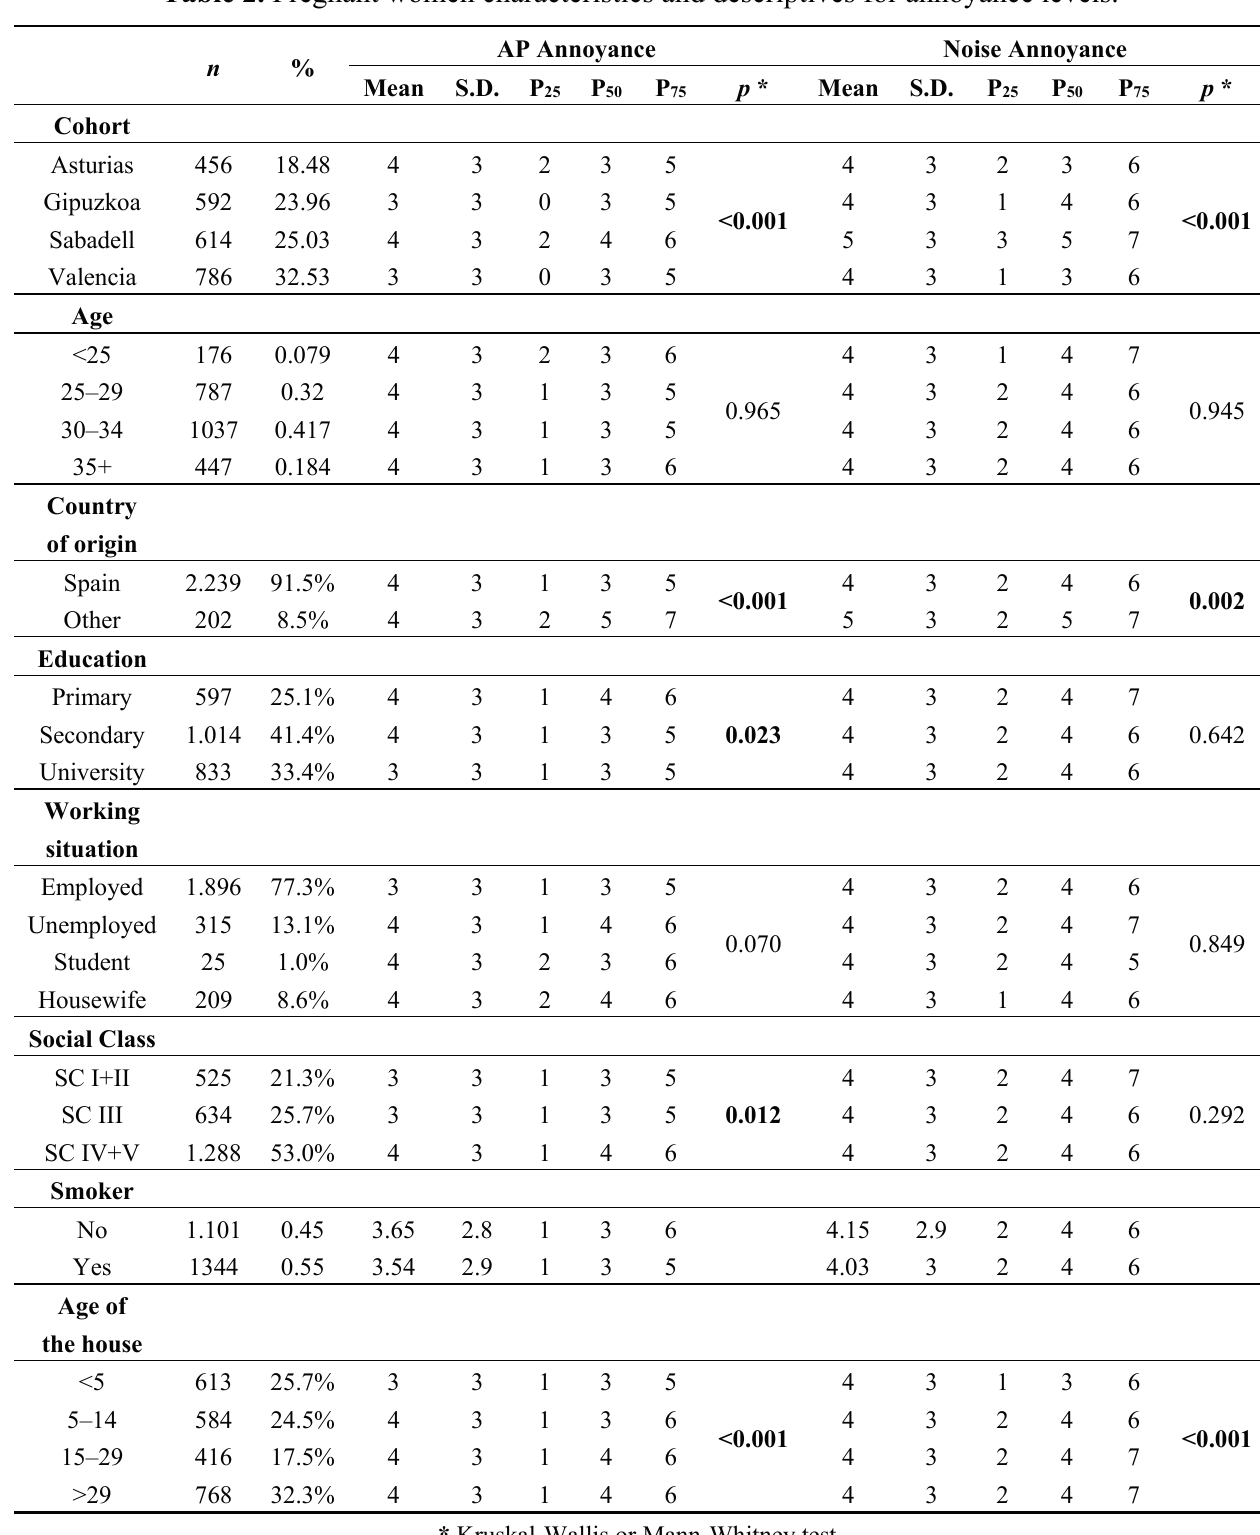
Table 2. Pregnant women characteristics and descriptives for annoyance